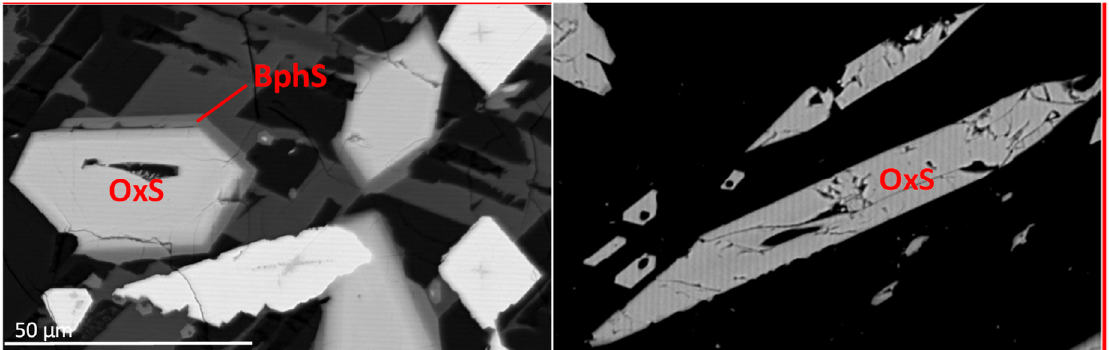
Figure 10. BSE(Z) micrograph of OxS/BphS grains in ASSB-7 ( left ), and OxS grains in ASSB-10 ( right ). An element distribution profile shows a sharp but still continuous transition between BpHS and OxS, indicating a (limited) solid solution (Figure 11).